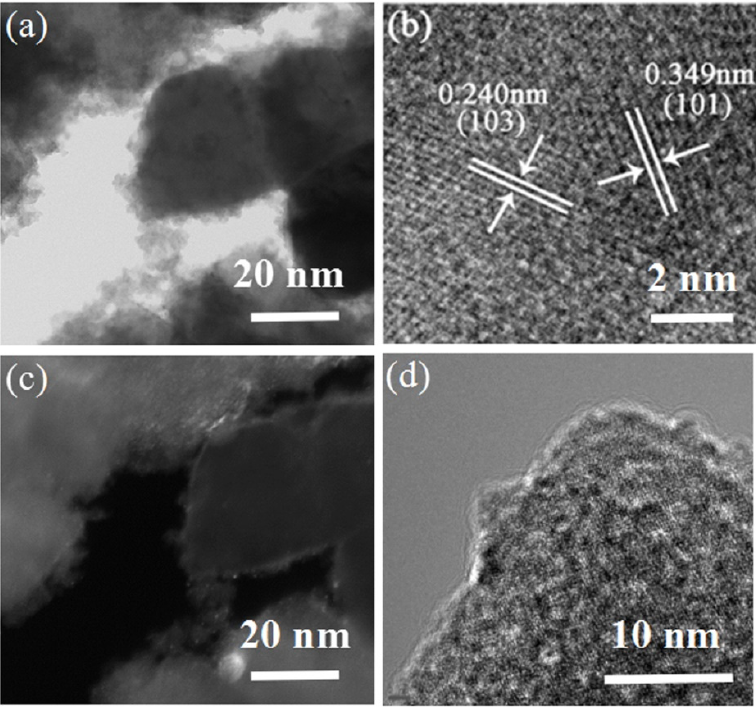
Figure 3. ( a – d ) TEM and HRTEM image of PbTiO 3 -TiO 2 nanocomposite by TBOT: 2. 0 mL (S3).